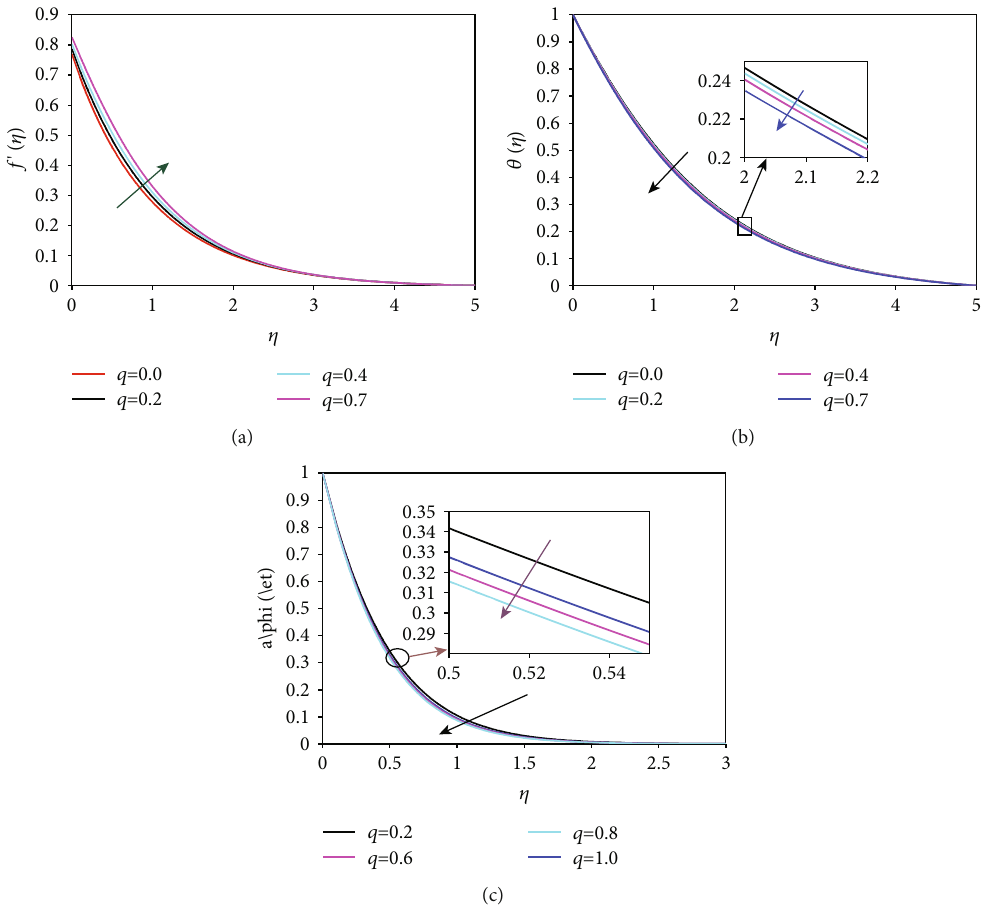
Figure 10: The graph of velocity, temperature, and concentration for di ff erent values of concentration buoyancy parameter ( q